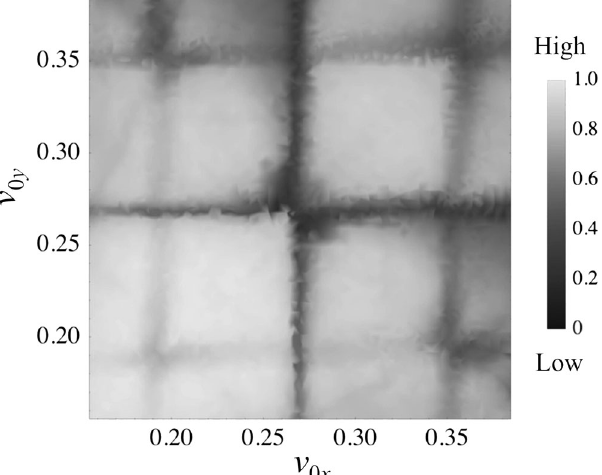
FIG. 23. Tune diagram experimentally obtained with S-POD [31]. The number of ions remaining in the LPT after 10 4 AG periods is measured at 4450 different operating points. The initial ion number N is fixed at about 10 7 in this example. The ion shading of gray scale represents the rate of surviving ions. The ion-loss rate is higher in the area of a darker shade.